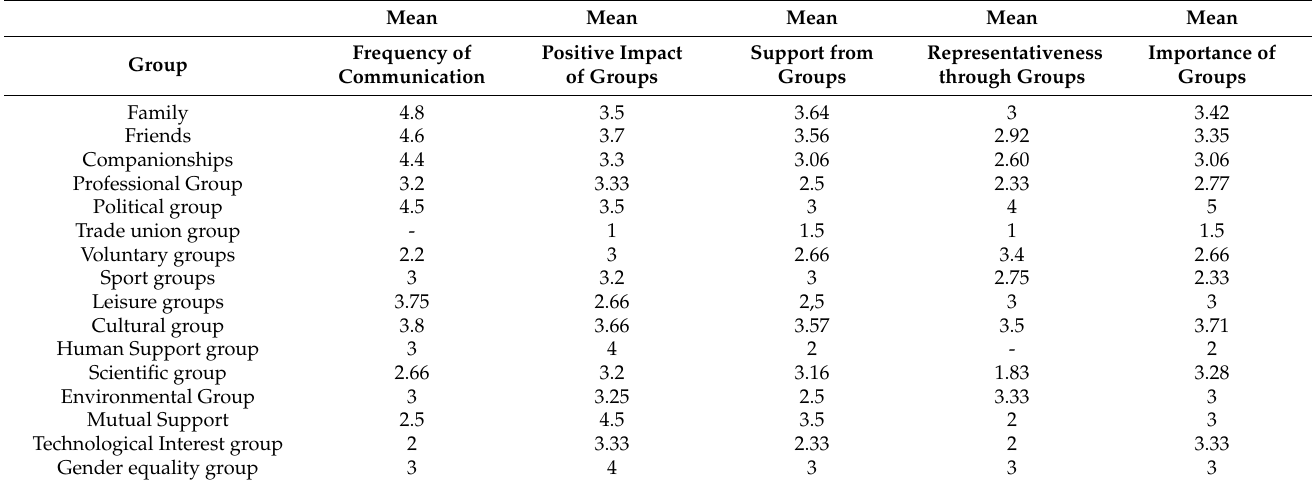
Table 9. Interaction with Social Groups within Social